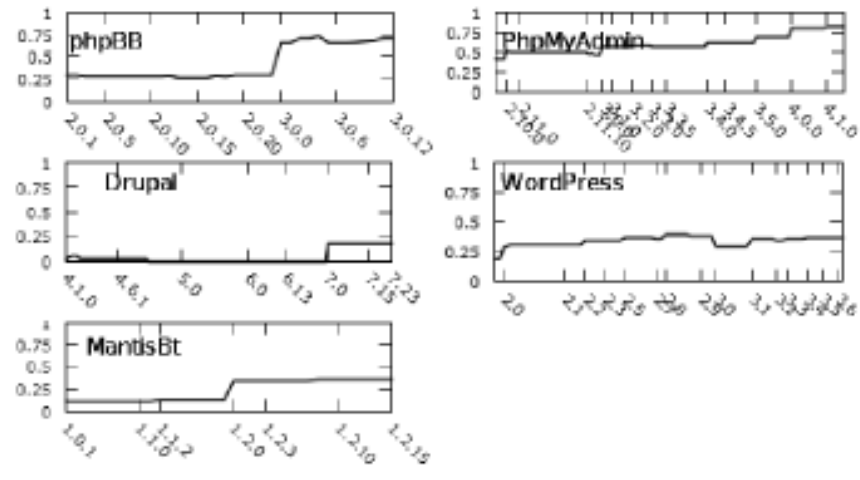
Fig. 5. Methods ratio over total number of functions and